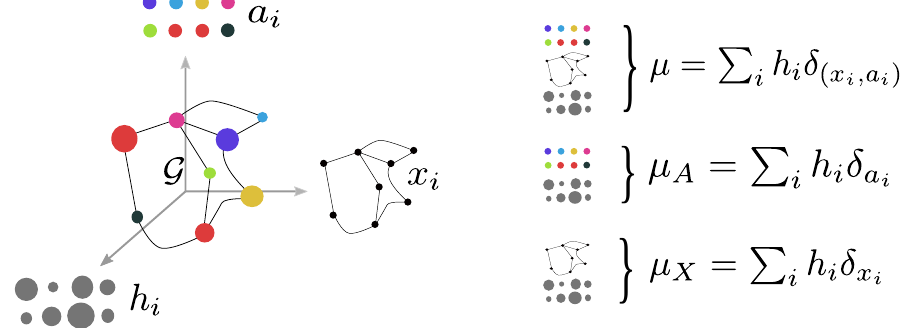
Figure 1. Discrete structured object ( left ) can be described by a labeled graph with ( a i ) i the feature information of the object and ( x i ) i the structure information. If we enrich this object with a histogram ( h ) i i aiming at measuring the relative importance of the nodes, we can represent the structured object as a fully supported probability measure µ over the couple space of feature and structure with marginals µ X and µ A on the structure and the features respectively ( right